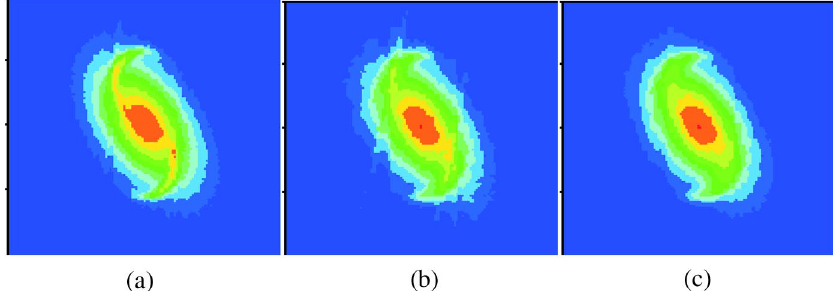
FIG. 2. (Color) Recovered phase-space density distributions of the phantom in the Y - Y 0 plane using various numbers of ‘‘measured" and interpolated projections. (a) 32 projections, (b) 16 projections, (c) 16 projections and 16 interpolations.